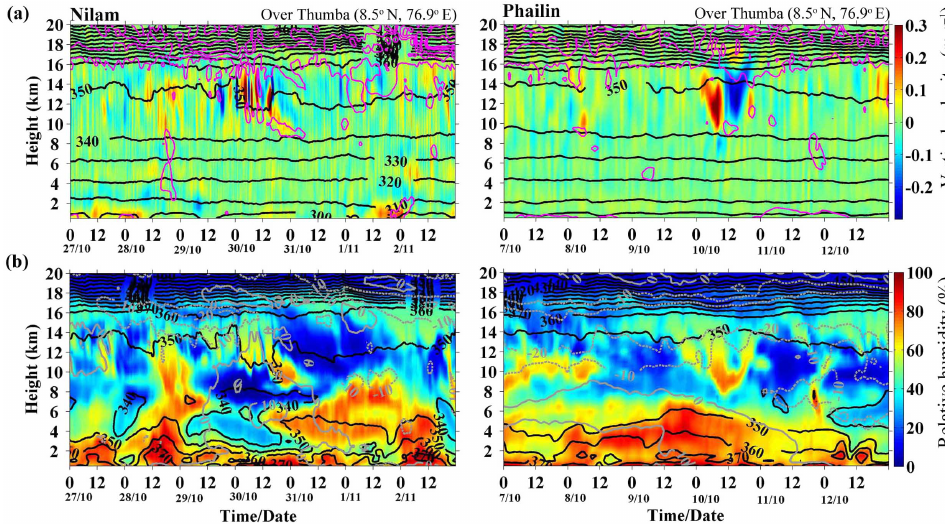
Figure 5. Height-time cross section of (a) vertical velocity along with potential vorticity (magenta line) and potential temperature (black line) contours, and (b) relative humidity along with equivalent potential temperature (black line) and zonal wind (grey line) for Nilam (left panels) over Trivandrum (8.5 ◦ N, 76.9 ◦ E) from 27 October to 2 November 2012 and Phailin (right panels) from 7 to 12 October 2013. Rectangular boxes indicate the presence of strong updraughts and downdraughts and the dry air between stratosphere and troposphere. The above parameters are obtained from the WRF simulation.